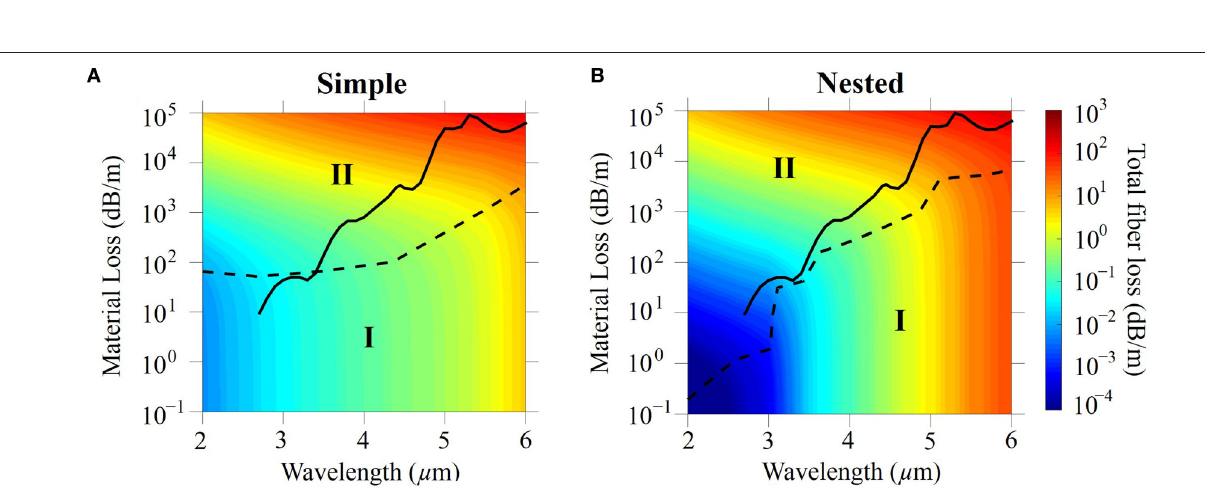
Frontiers in Physics | www.frontiersin.org